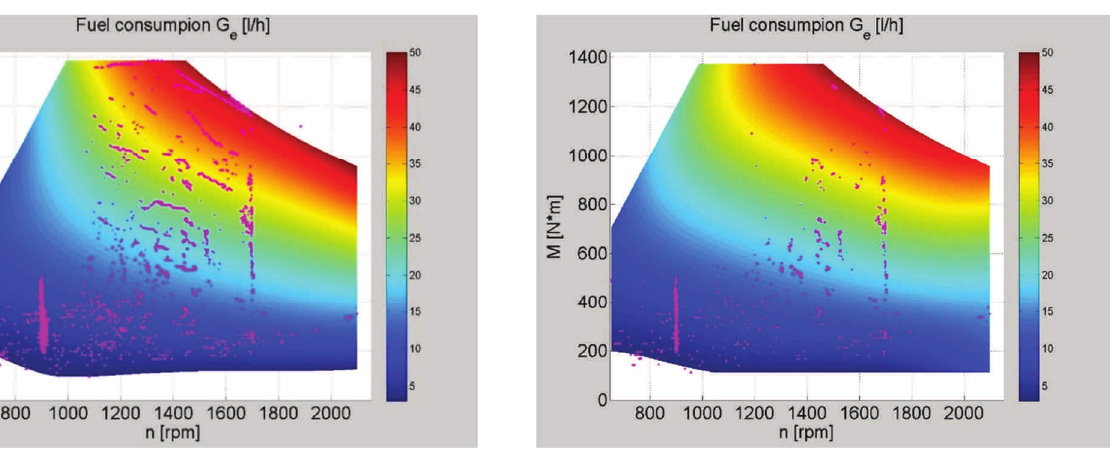
Fig. 5. Characteristics obtained from operational data: static state duration 0.5 s; derivative limits: 5 N ∙ m/s, 5